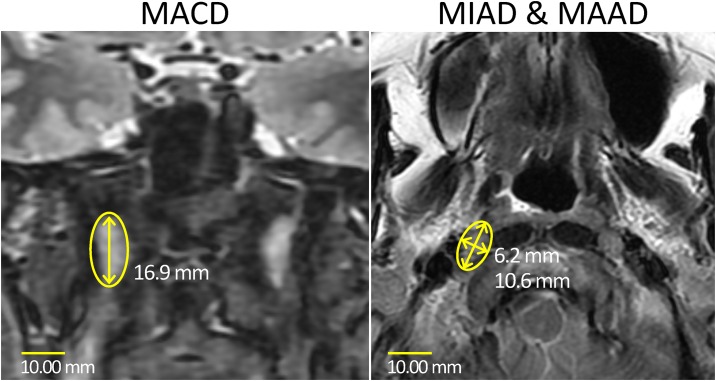
Measuring the three diameters of a right lateral retropharyngeal node.This image was obtained from a 48-year-old NPC woman with a lateral retropharyngeal lymph node (yellow circled) on a T2-weighted MRI. (a) In axial plane, the MAAD (10.6 mm) should be measured first, and the MIAD (6.2 mm) should then be measured in the perpendicular direction. (b) Coronal plane of image showing that the MACD (16.9 mm) of the node can be measured using an electronic caliper easily. NPC, nasopharyngeal cancer; MIAD, minimal axial diameter; MAAD, maximal axial diameter; MACD, maximal coronal diameter.